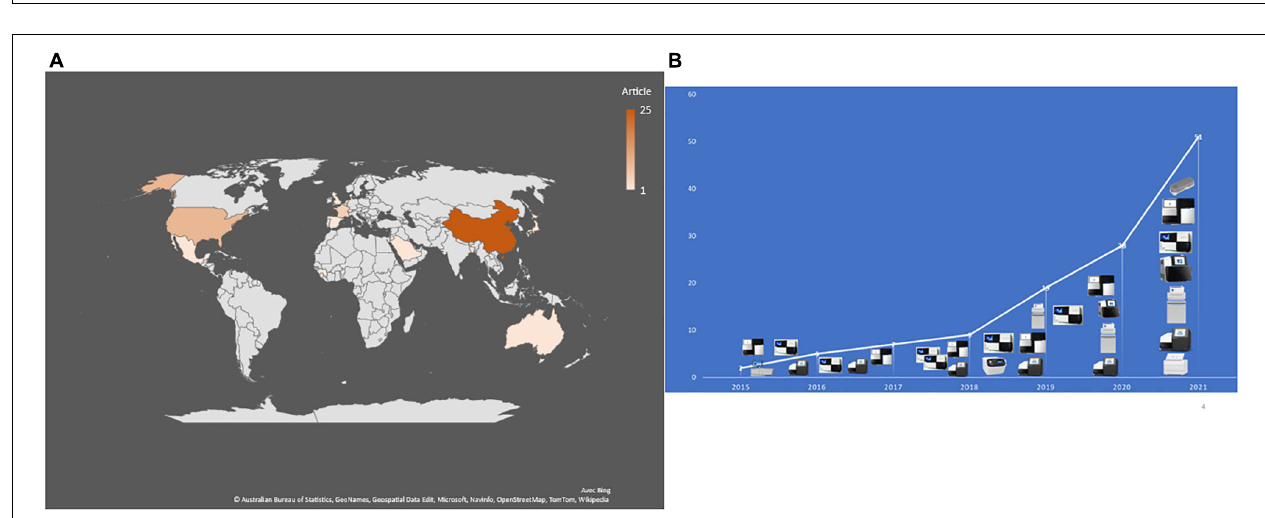
FIGURE 1 | Prisma diagram of eligible articles recorded after removing duplications. Six bibliographic databases were reviewed using the following key words: "metagenomic," “diagnosis,” “meningitis,” “encephalitis,” “next generation sequencing,” and “cerebrospinal fluid,” used alone and/or in combination. Only 51 articles were eligible for this review, after screening according to the inclusion criteria described above.